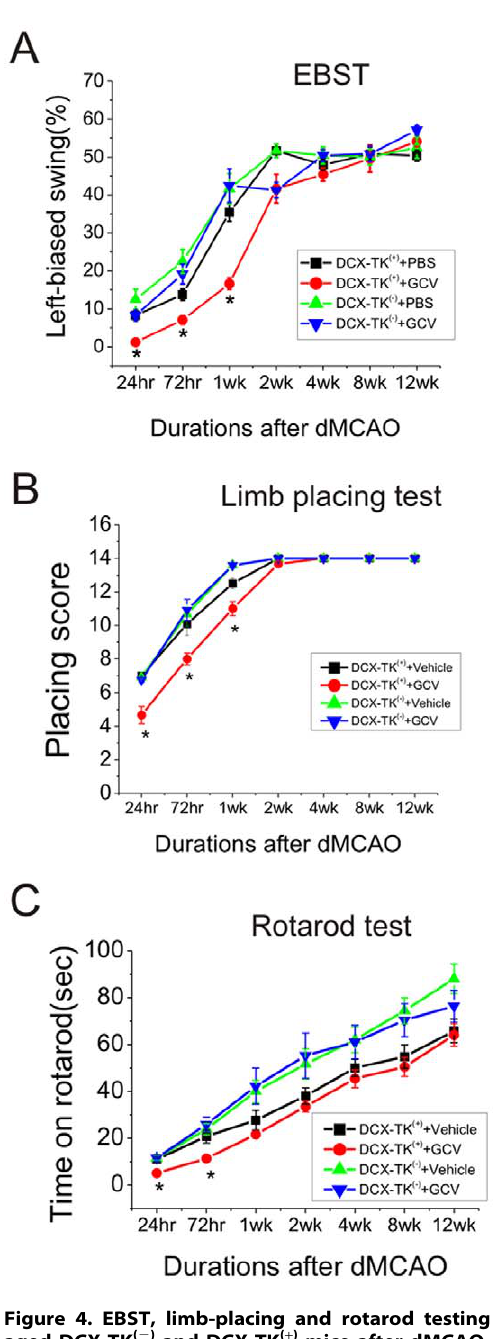
Figure 4. EBST, limb-placing and rotarod testing in middle- aged DCX-TK ( 2 ) and DCX-TK ( + ) mice after dMCAO. Middle-aged DCX-TK ( 2 ) and DCX-TK ( + ) mice underwent dMCAO after treated with vehicle or GCV for 14 days, then behavioral tests were conducted at intervals over the next 12 wks. ( A ) Scores of elevated body swing test (EBST; lower scores correspond to more severe deficits). ( B ) Scores of limb-placing test (lower scores represent more severe deficits). ( C ) Scores of rotarod test (lower scores represent more severe deficits). * P ,